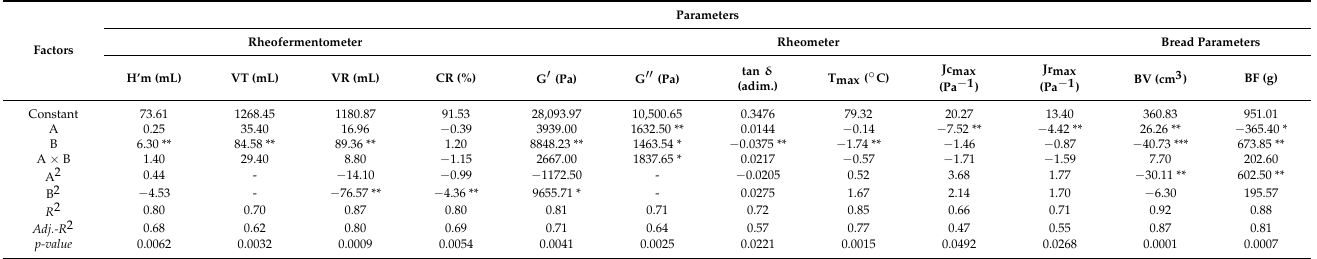
Table 4. The coefficients in the predictive models for dough during fermentation, dynamic rheological properties, and bread